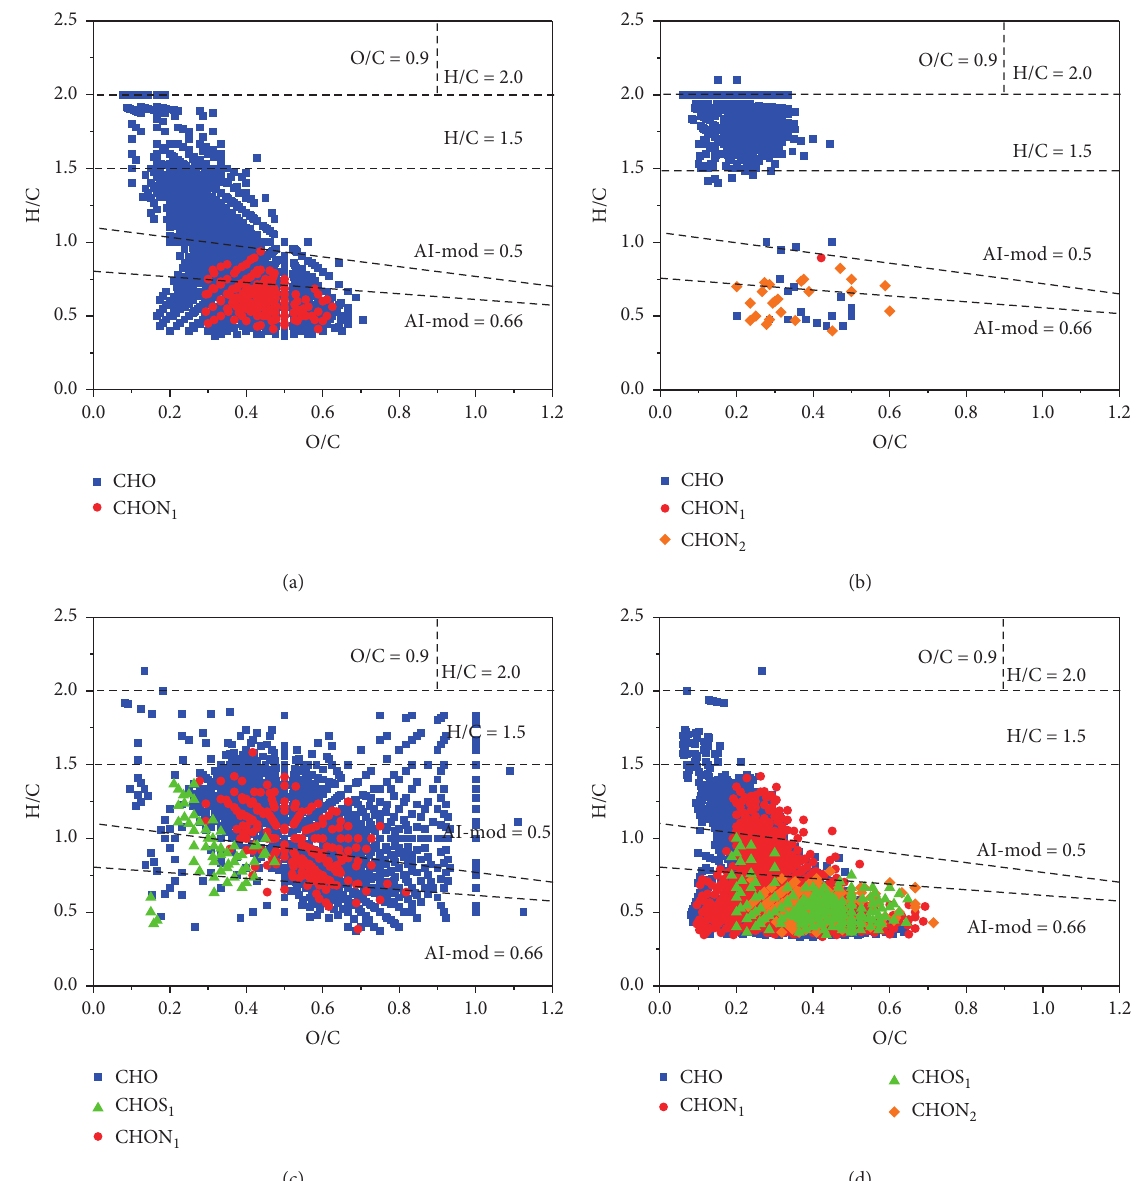
Figure 4: Van Krevelen diagrams of molecular formulas (a) common among all humic acid samples, (b) identified only in humic acids from Jiufeng forest soil, (c) identified only in humic acids from Suwannee River, and (d) identified only in humic acids from leonardite. Formulas include CHO (blue), CHOS 1 (green), CHON 1 (red), and CHON 2